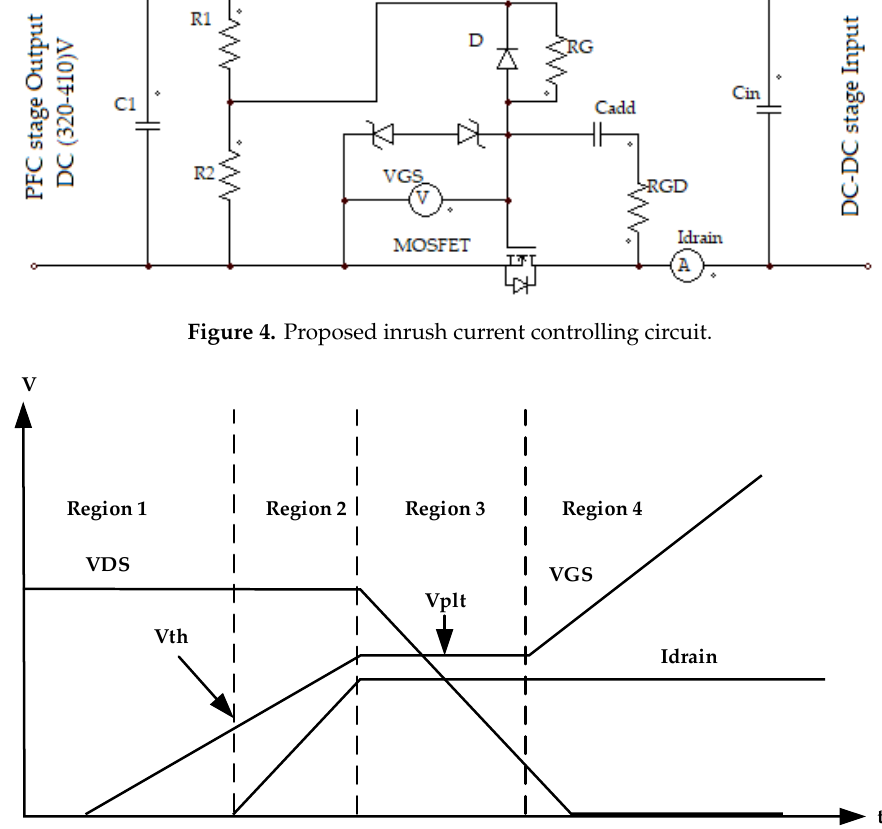
Figure 5. Gate charge transfer characteristics of MOSFET.